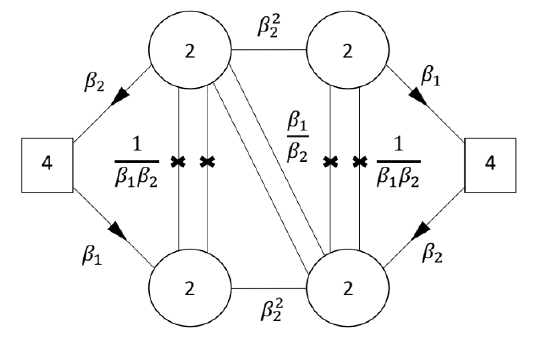
Figure 31 . The theory resulting from gluing the tubes I and III